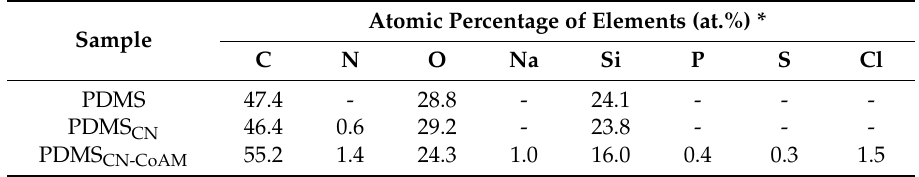
Table 3. Elemental analysis of the coated and inactivated silicone surfaces by XPS (the surface depth ≈ 10 nm). Atomic Percentage of Elements (at.%) * Sample